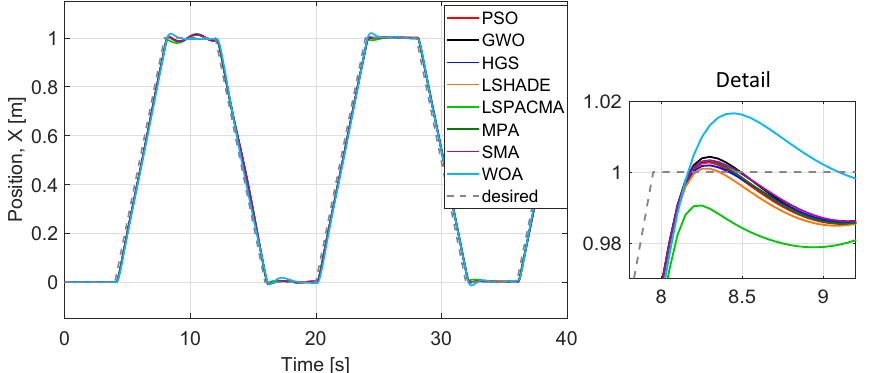
Figure 6. Comparison of tracking performance in X–axis of the different algorithms evaluating parameters obtained with 20 individuals.